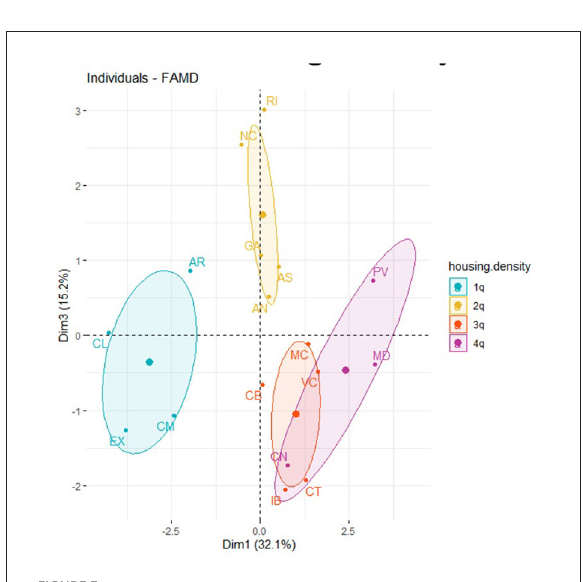
FIGURE3 ACS clustering: Five clusters identified by